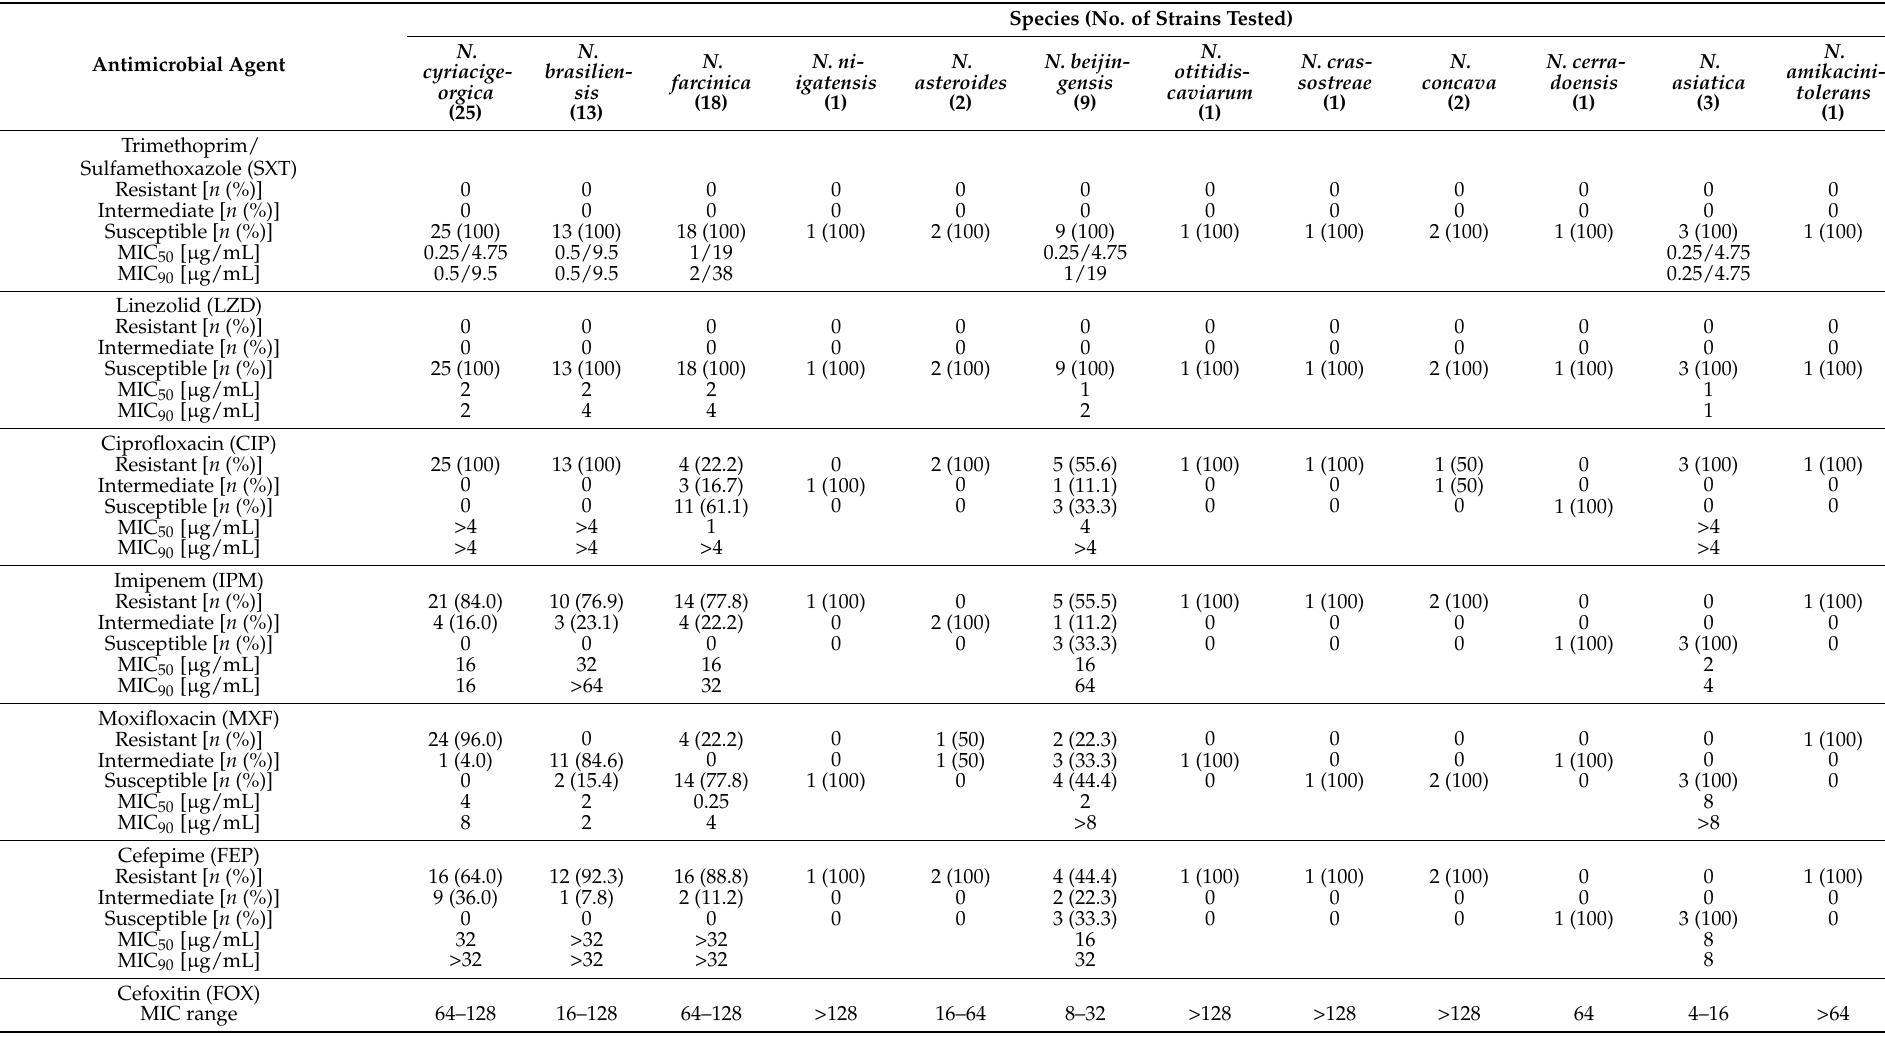
Table 3. The antimicrobial susceptibility test